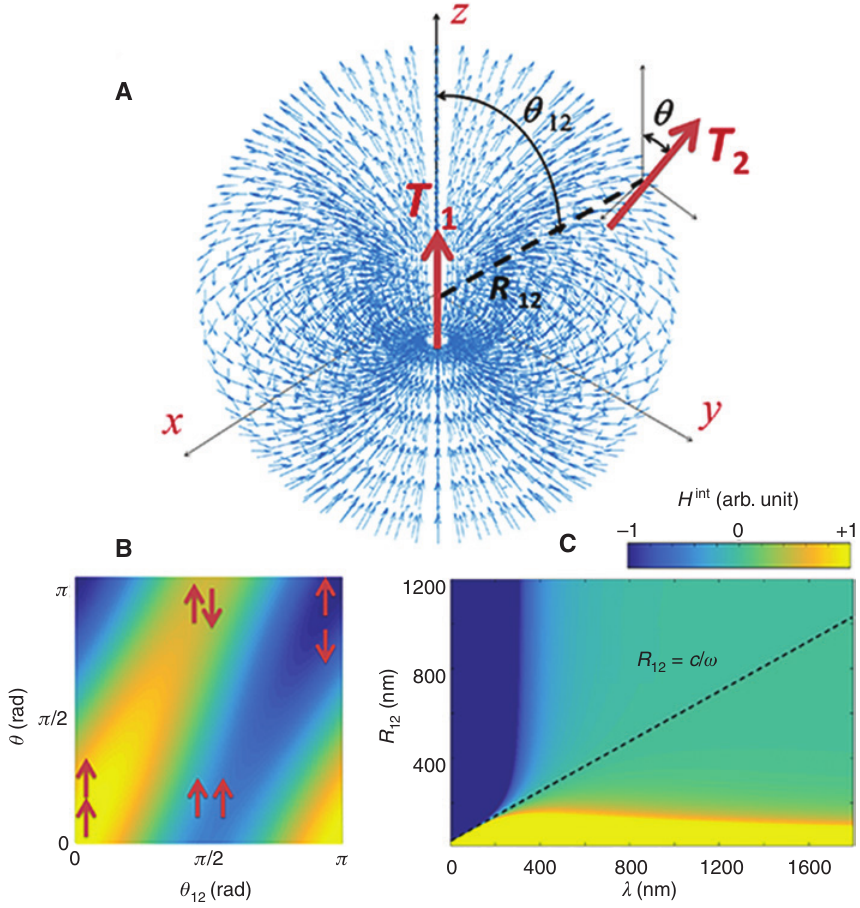
Figure 5: Toroidal field profile and the interaction energy between two toroidal dipoles. (A) Electric-field configuration associated with a toroidal dipole moment positioned at the origin of the coordinate system. Another toroidal dipole moment positioned at the proximity of the original toroidal dipole moment can couple with it. (B) The interaction energy of two and θ and (C) versus the wavelength and the distance between them. Positive and coupled toroidal moments versus the polar angles θ 12 negative interaction energies produce the higher- and lower-energy states in a hybridization picture, respectively. The arrows show the orientation of toroidal moments. The color bar is identical for (B) and